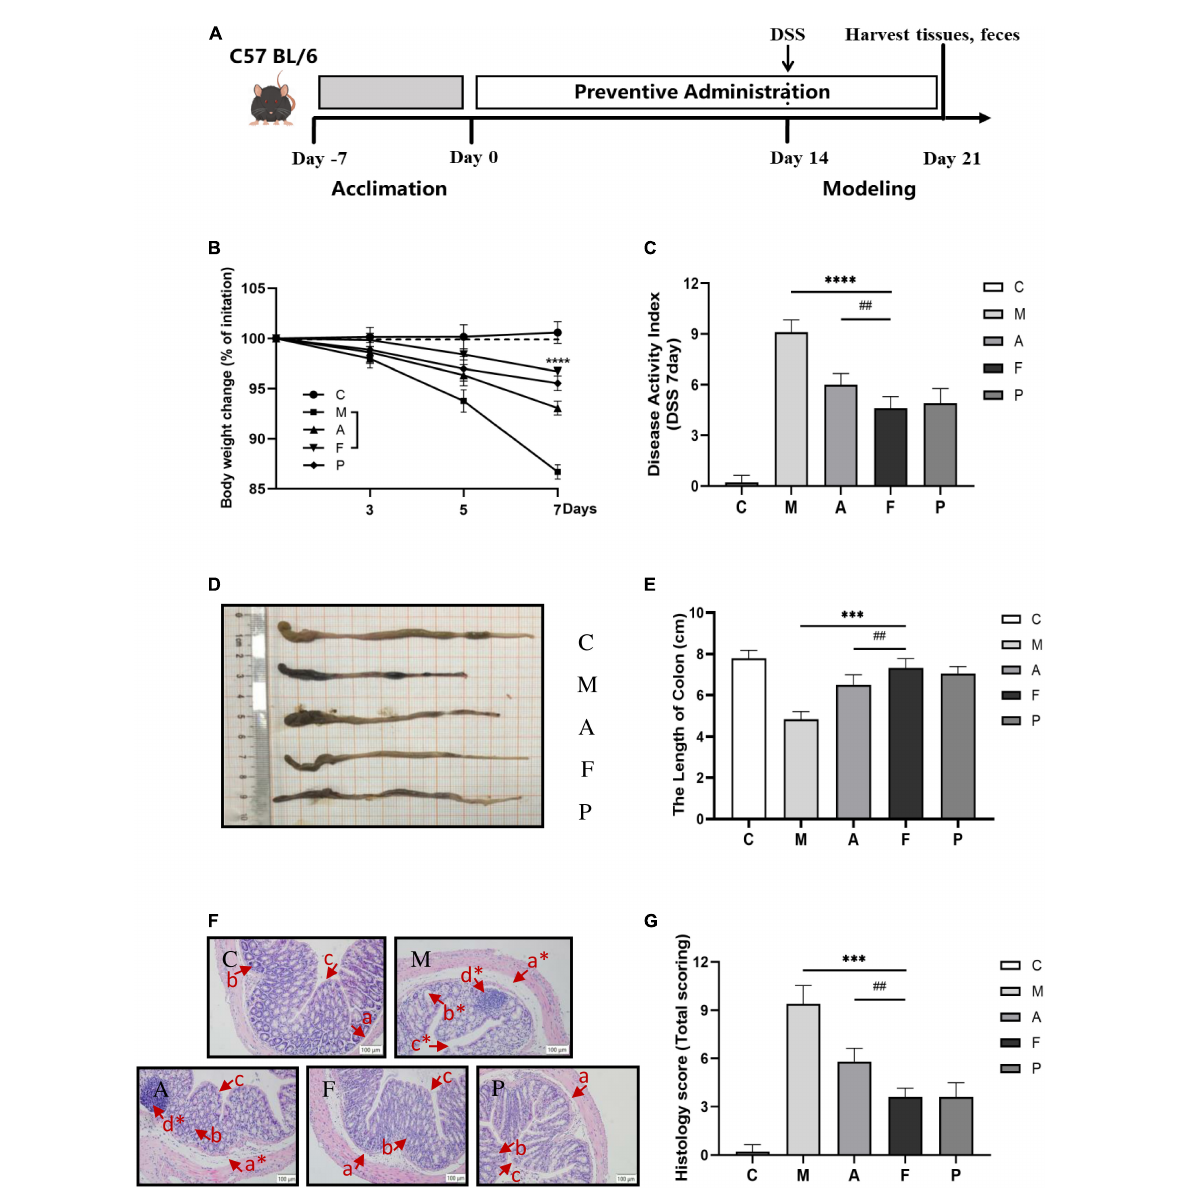
FIGURE1 FA alleviated the severity of DSS-induced colitis in mice: (A) schematic diagram of the animal experiment; (B) FA ameliorated the body weight loss associated with the dextran sulfate sodium (DSS)-induced colitis in mice; (C) DAI score; (D) representative images of colon tissues; (E) colonic lengths from different groups; (F) representative Hematoxylin and Eosin (H&E)-stained colon sections are shown at 20 × magnification. The same locations are marked with the same symbols. (a) Edema in loose connective tissue ( ∗ moderate edema); (b) crypt and goblet cell ( ∗ crypt distortion and loss of goblet cells); (c) epithelial layer ( ∗ broken epithelial layer); (d) inflammatory infiltration; (G) the histological score of the colons. Data are mean ± SD ( n = 6). ∗∗∗ P ≤ 0.001 and ∗∗∗∗ P ≤ 0.0001 vs. the M group; ## P ≤ 0.01 vs. the A